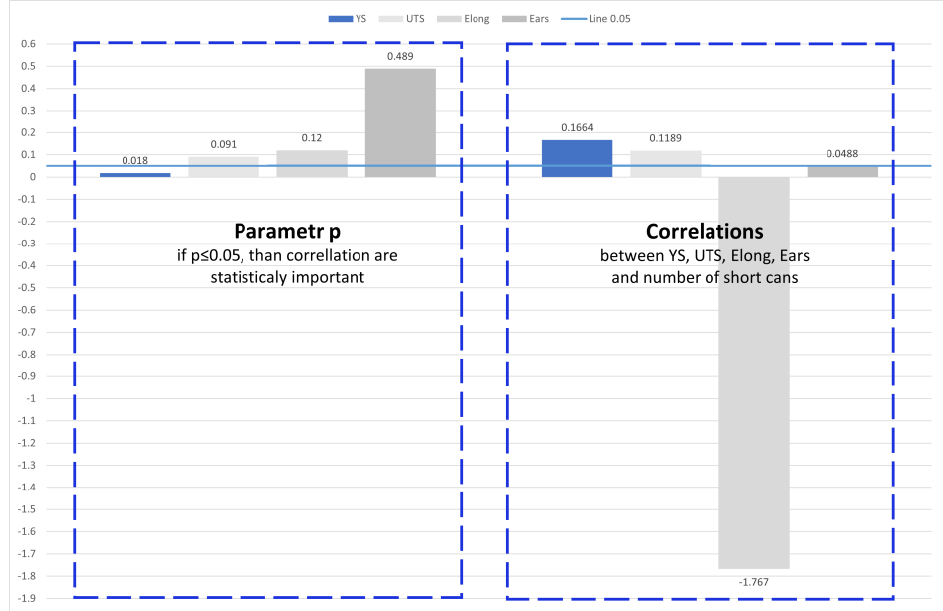
Figure 5. Graphical representation of correlations and p values of these correlations for mechanical parameters.